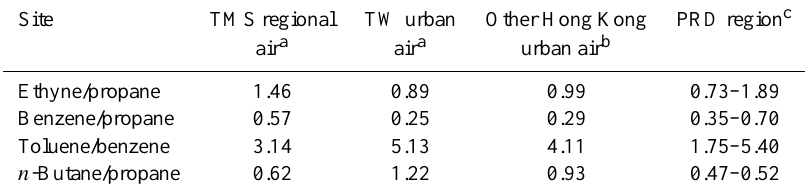
Table 2. Comparison of VOC ratios for TMS regional air, urban Hong Kong and PRD region.